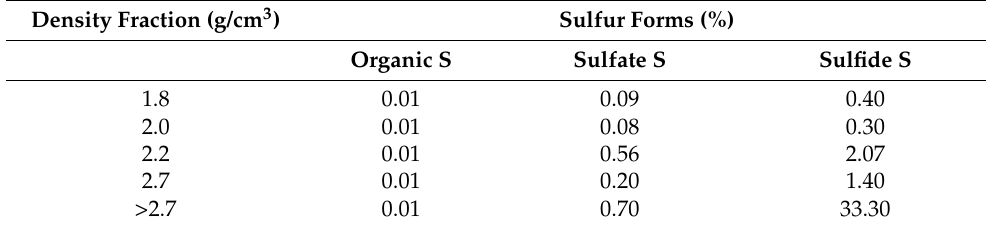
Table 6. Sulfur speciation of five fractions obtained from sink-float studies.